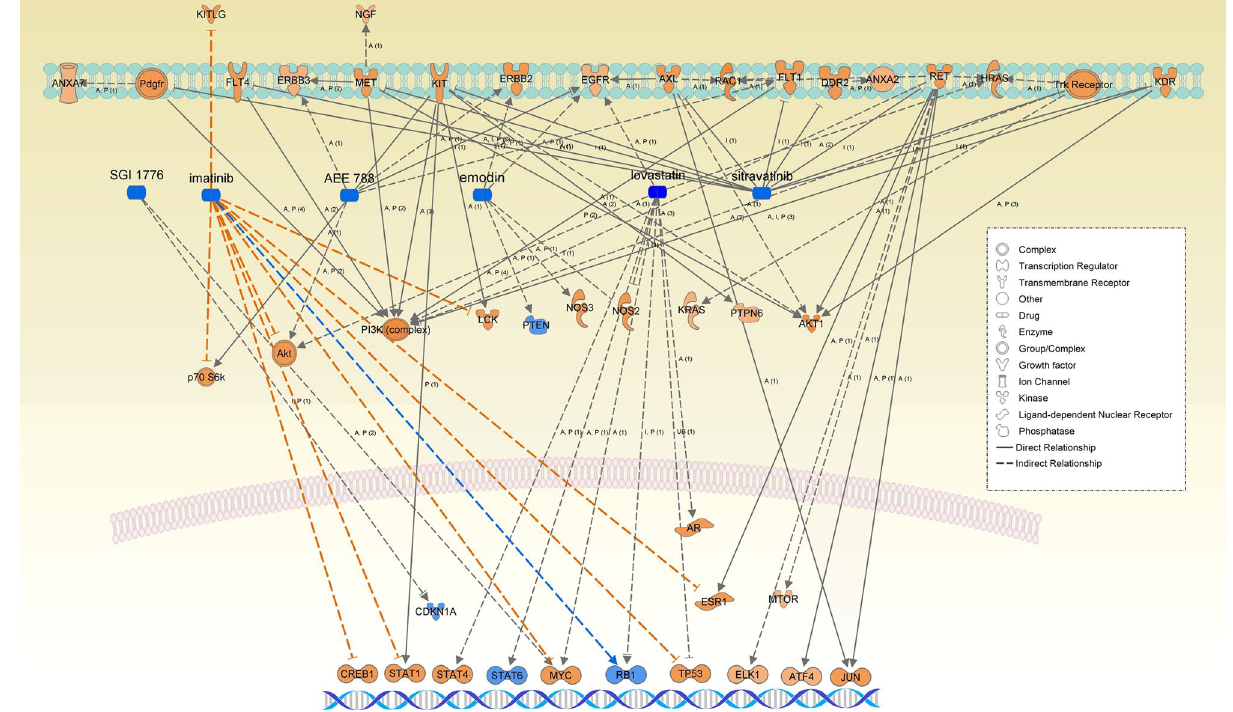
Figure 6. The causal networks of chemical drug interventions (SGI-1776, imatinib, emodin, lovastatin, AEE788, and sitravatinib) are predicted to be highly inhibited in the WM5 (cyan) network